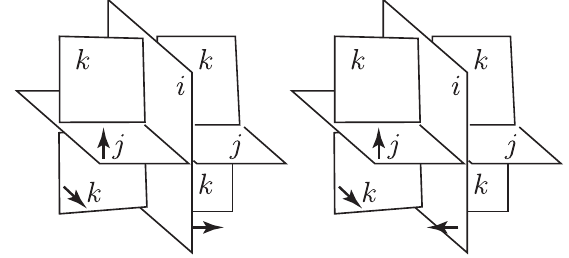
FIG. 10. A positive triple point (left) and a negative triple point (right), where we denote the orientations of sheets by their